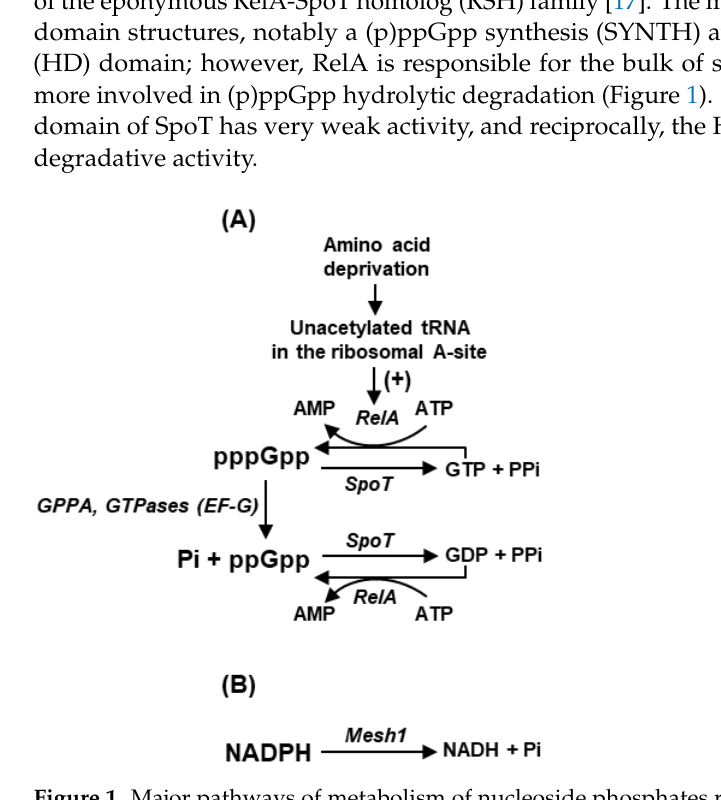
Figure 1. Major pathways of metabolism of nucleoside phosphates relevant in stringent response. ( A ) The synthesis of the two guanosyl phosphates, ppGpp and pppGpp, in bacteria is catalyzed in